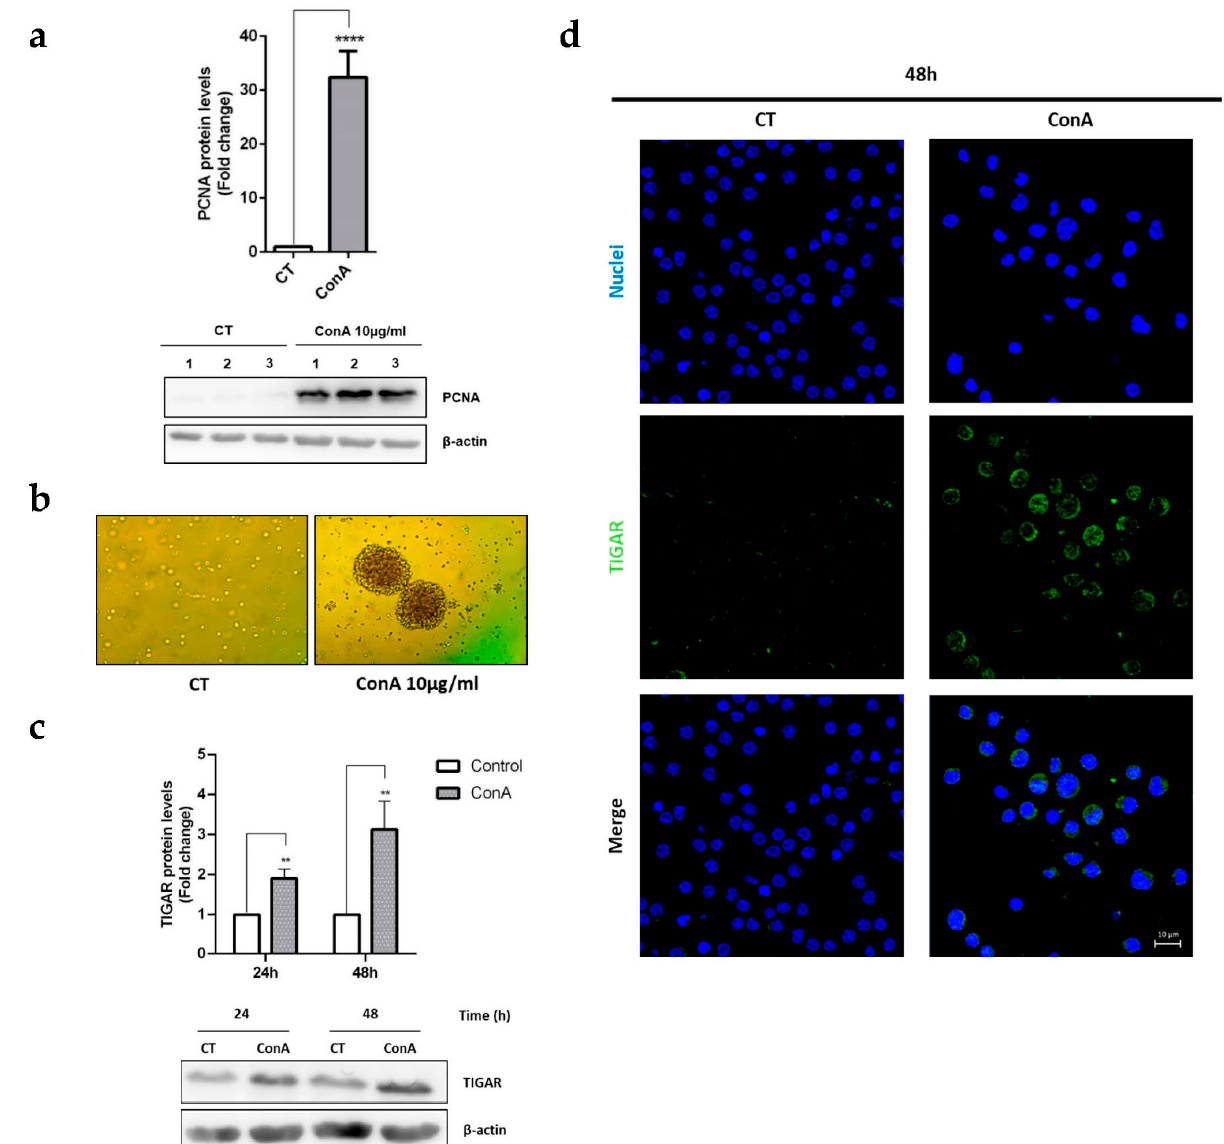
Figure 1. TIGAR is induced in parallel to the proliferation marker PCNA in ConA-stimulated human lymphocytes. ( a ) Western blot image and quantification of PCNA levels normalized to β -actin in response to 10 µg/mL ConA at 48 h. Representative images of three different samples are shown. ( b ) Optical microscopy images of control and ConA-treated T lymphocytes at 48 h. ( c ) Western blot analysis of TIGAR normalized to β -actin in 10 µg/mL in ConA-treated and untreated (Ct) lymphocytes at 24 h and 48 h. A representative image is shown. ( d ) Image of a representative immunofluorescence analysis of TIGAR in ConA-treated lymphocytes at 48 h. Nuclei were detected with DRAQ5 (Thermo Fisher). All data are presented as a mean fold change relative to untreated cells ± SEM. Differences were calculated with two-tailed unpaired Student’s t -test with a normal-based 95% CI. Significant p values are indicated; ** p < 0.01; **** p < 0.0001; n = 3.